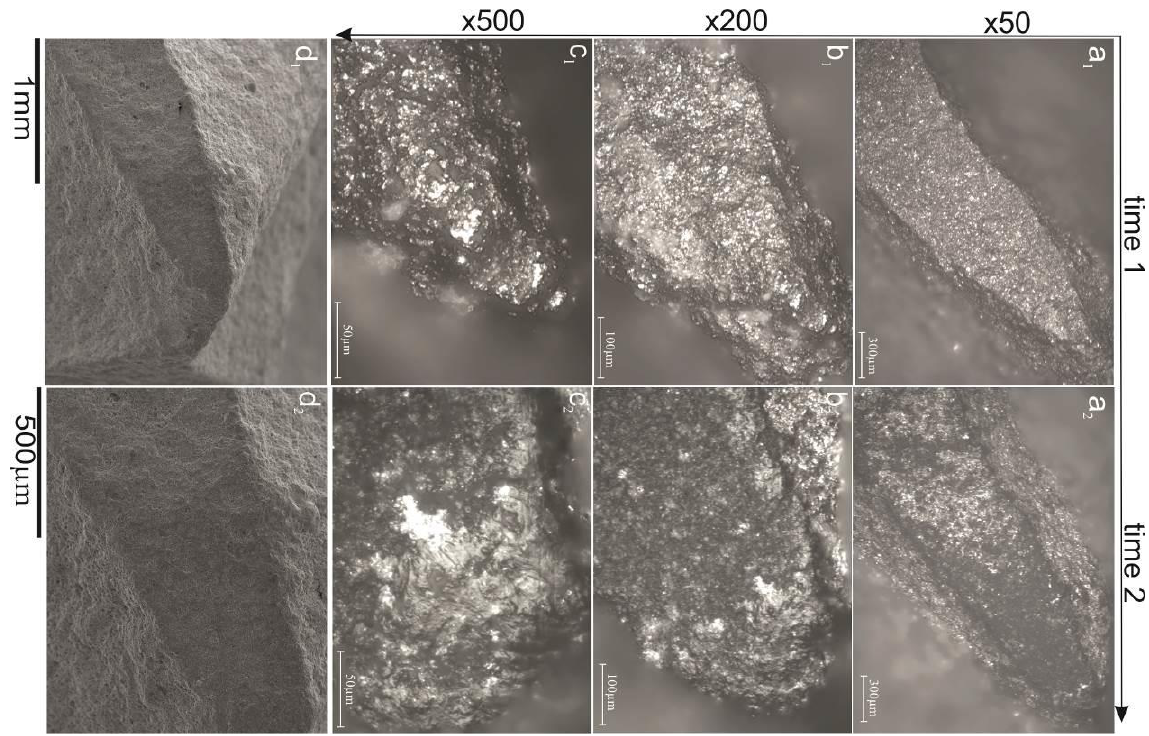
Figure 10. An example of important mechanical alteration of the ridges on the PDSM experimental pieces seen under the optical microscope at x50 (a hours of tumbling; d